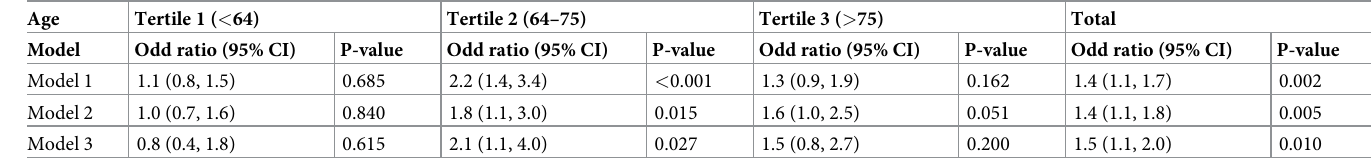
Table 4. The association between MACC1 and lymphatic metastasis after stratifing age (N = 297).